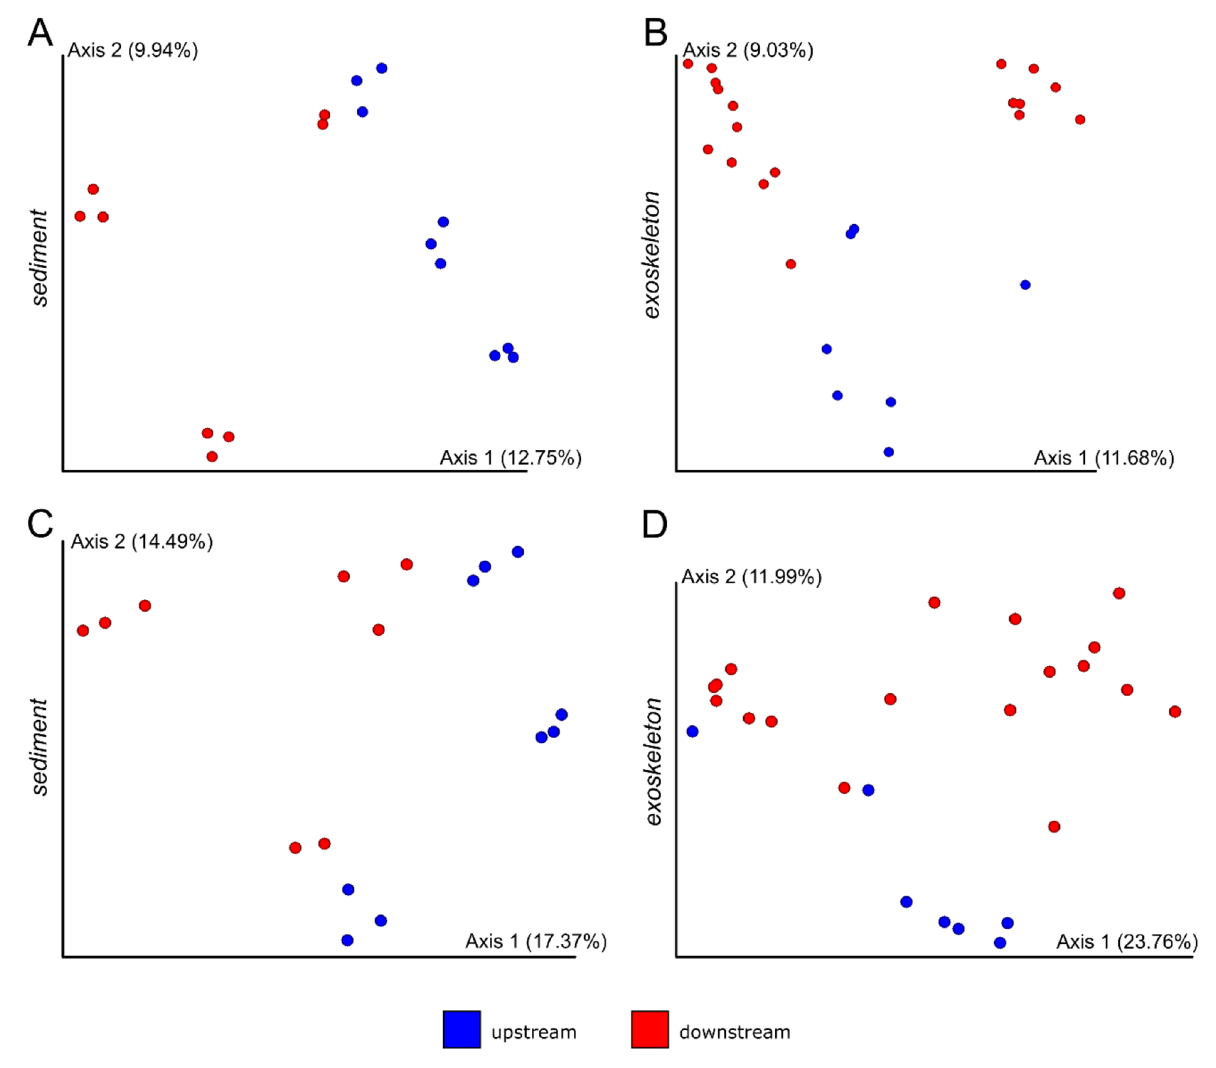
Fig. 5 Beta diversity analyses of (A,C) sediment and (B,D) exoskeletal mycobiomes between upstream and downstream river segments. The PcoAs are based on (A,B) Jaccard and (C,D) Bray-Curtis distance